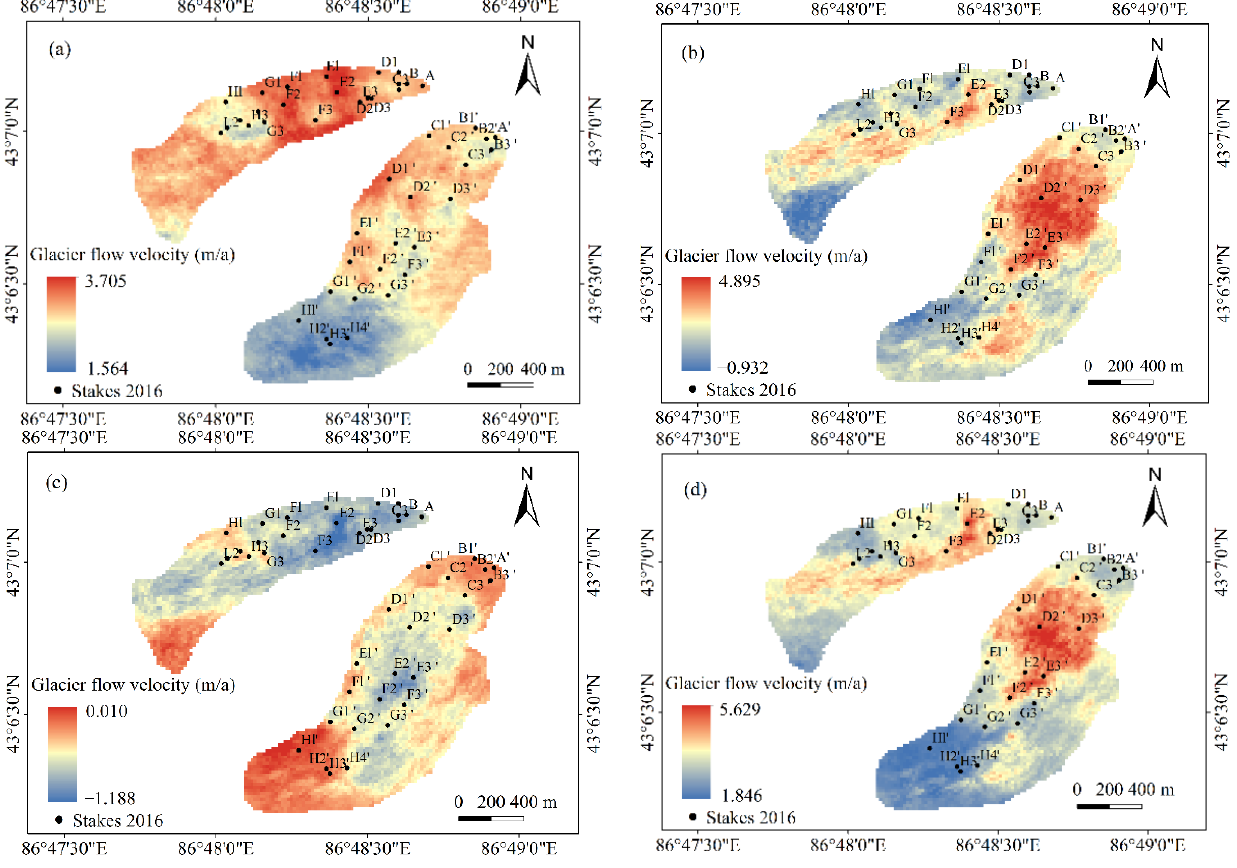
Figure 7. Spatial distribution map of glacier velocity from 2016 to 2017. ( a ) Velocity in the east direction; ( b ) Velocity in the north direction; ( c ) Velocity in the vertical direction ( d ) Three-dimensional velocity of Urumqi Glacier No.1.